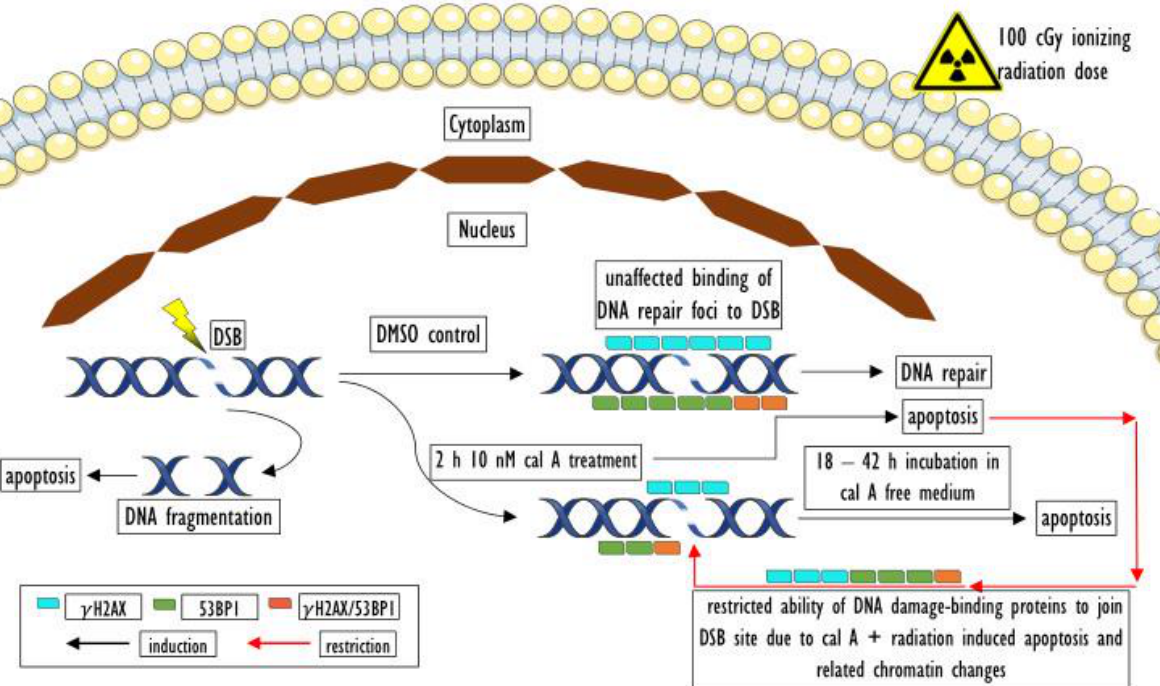
Figure 6. Possible explanation of low DNA repair foci level in 10 nM cal A + 100 cGy treated UCBL 2 h posttreatment. Our assumption is that cal A + 100 cGy irradiation-induced apoptosis and related changes in chromatin structure prevent DNA damage-binding proteins from accessing the DSB site. Thus, lower numbers of DNA DSB repair foci could be detected in irradiated and cal A 10 nM treated cells than in irradiated cells.